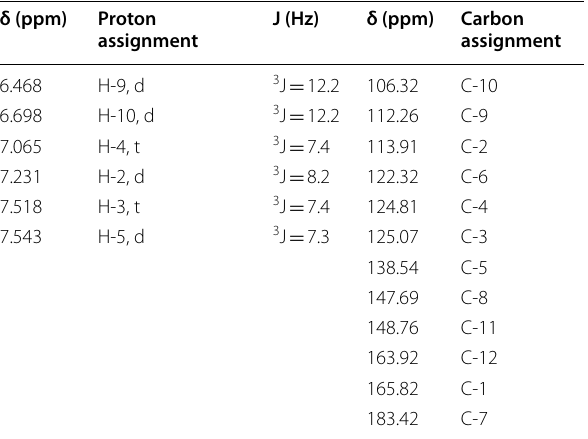
Table 1 1 H NMR (600 MHz) and 13 C NMR (150 MHz) results for silylated HOBB in DMSO- d 6